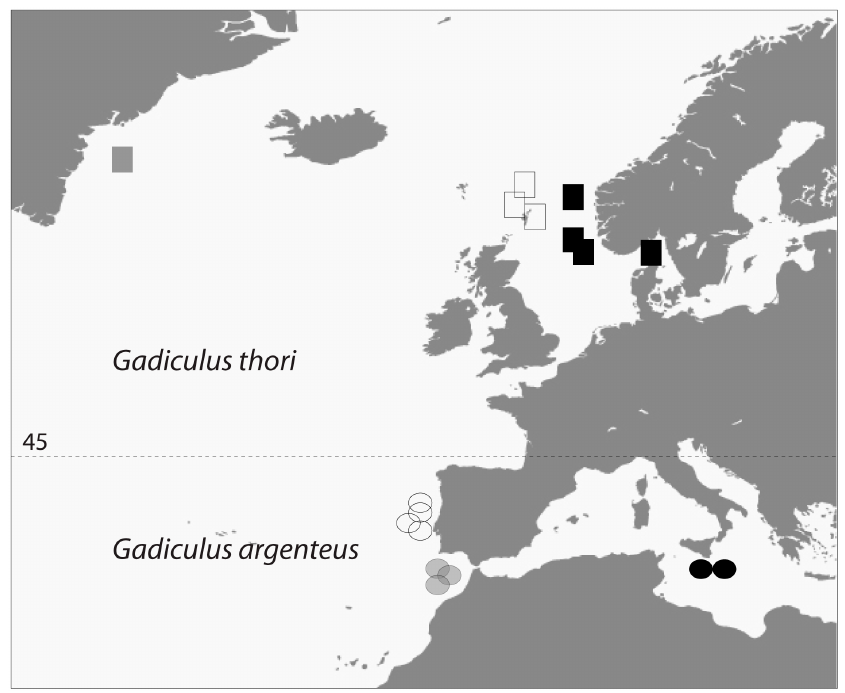
Figure 3. Catch localities of Gadiculus spp. used for molecular comparisons in this study (Table 2). Squares depict G. thori and circles depict G. argenteus with shading corresponding to specimens presented in Figure 8. The dashed line at about 45° N is denoting the approximate boundary separating G. thori and G. argenteus in the Northeast Atlantic Ocean.